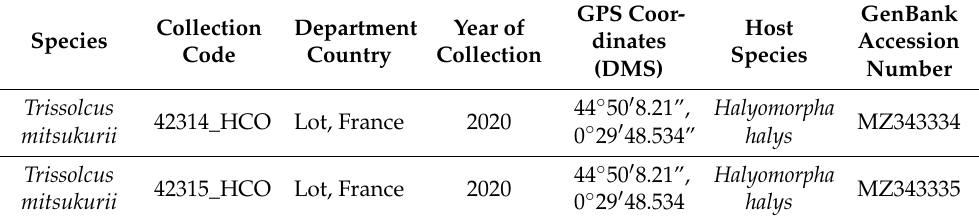
Table 2. GenBank accession number and sample information for COI sequences presented in this